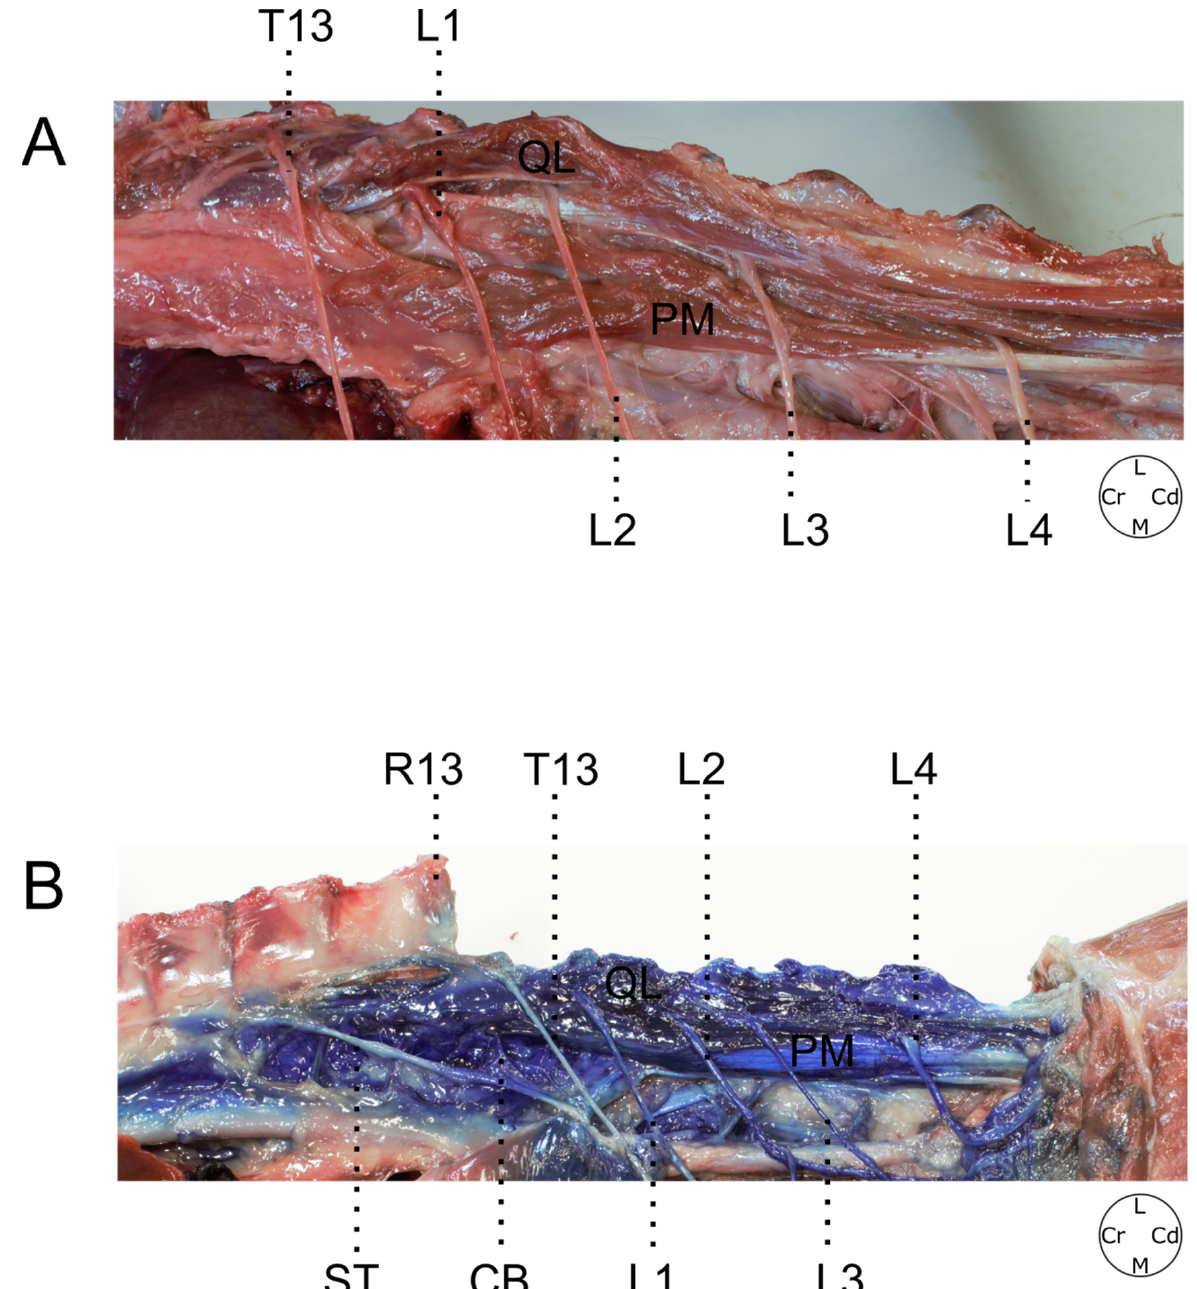
Figure 7. ( A ) Anatomical dissection of the thoracolumbar region. ( B ) Thoracolumbar region staining after methylene blue administration. T13; L1; L2; L3; L4, ventral branches of T13, L1, L2, L3 and L4 nerves respectively; QL, quadratus lumborum muscle; PM, psoas minor muscle; R13, 13th rib; ST, sympathetic trunk; CB, communicating branch; L, lateral; M, medial; Cr, cranial; Cd, caudal. The dissection demonstrated the presence of dye in the sympathetic trunk and com- municating branches after 8/10 injections in a median of 4 (0–7) vertebral segments. The staining of these structures occurred occasionally at a level of T10 10% (1/10), T11 20% (2/10), T12 30% (3/10) and L4 30% (3/10), and more consistently at the level of T13 70% (7/10), L1 80% (8/10), L2 80% (8/10) and L3 60% (6/10) (Figure 8). The injectate did not reach the sympathetic trunk in one of the cadavers (cadaver 4).